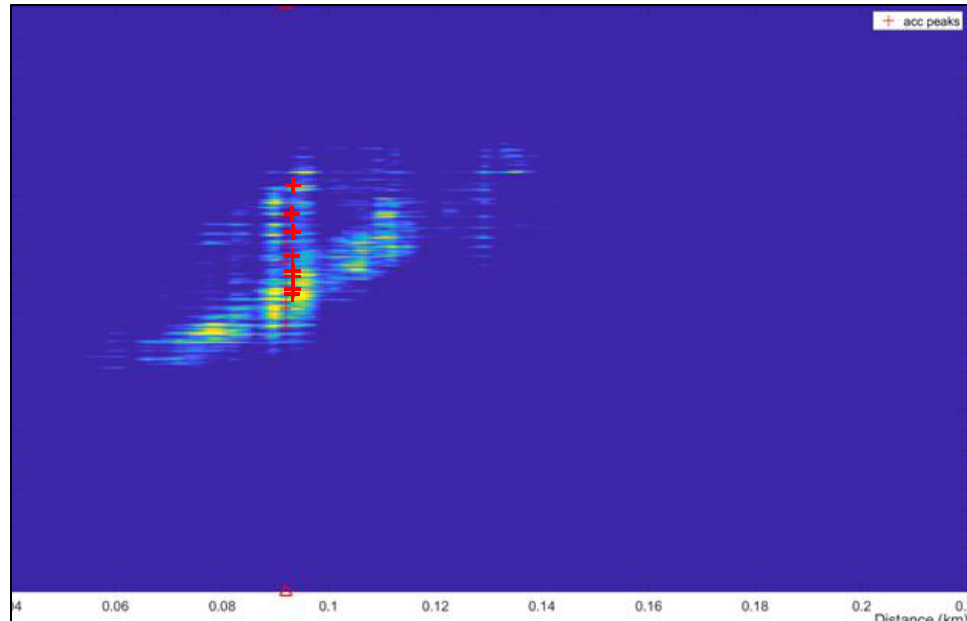
Figure 7 . Gradient analysis with a gap of 25 mm and a speed of 25 km/h. Vertical axis is time, horizontal axis is distance.